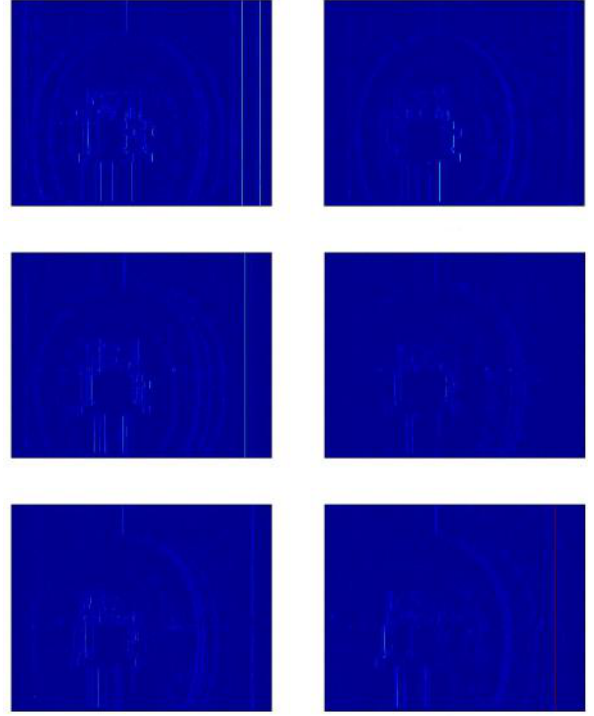
Figure 5. This figure shows six samples of the comparison between two sets of reconstructed images; one set produced using photogrammetrically computed measurements for the phantom position and orientation and the other using